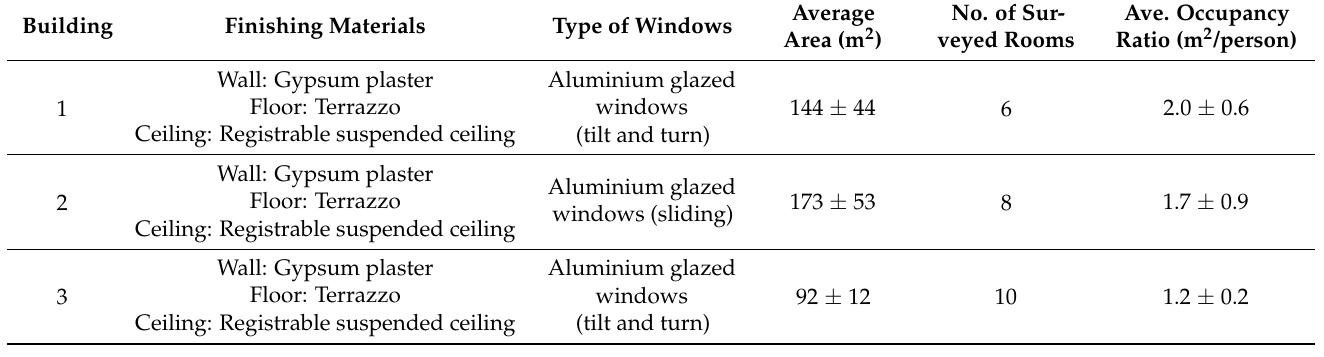
Table 1. Summary of the characteristics of the investigated buildings.